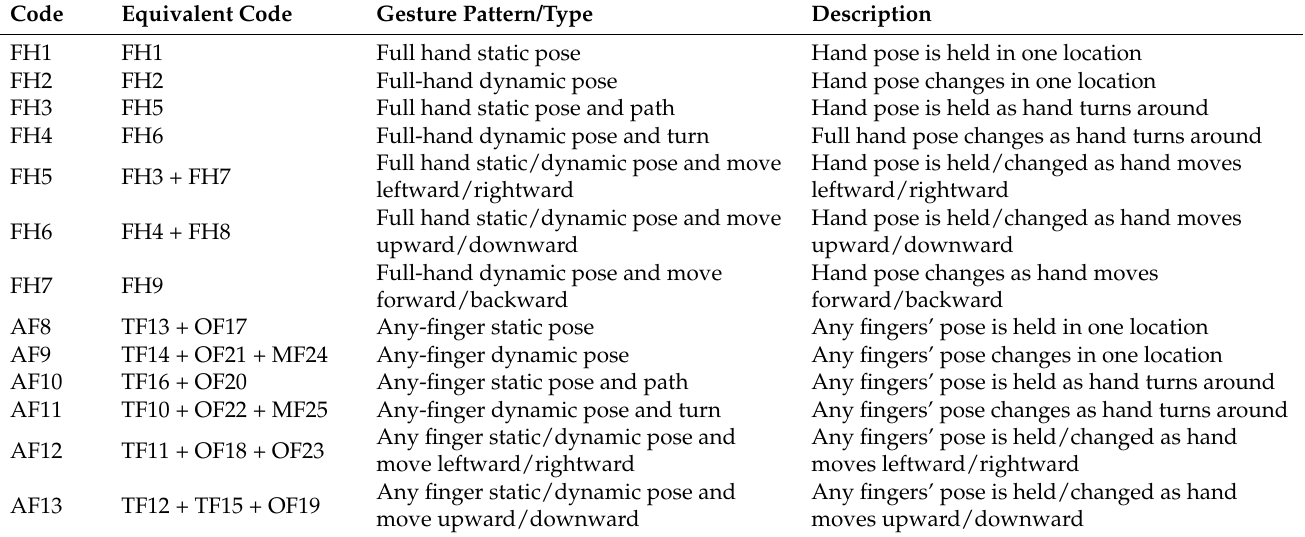
Table 5. Gesture code, equivalent codes from HomeG, pattern and description for CrossG for controlling an AC system across